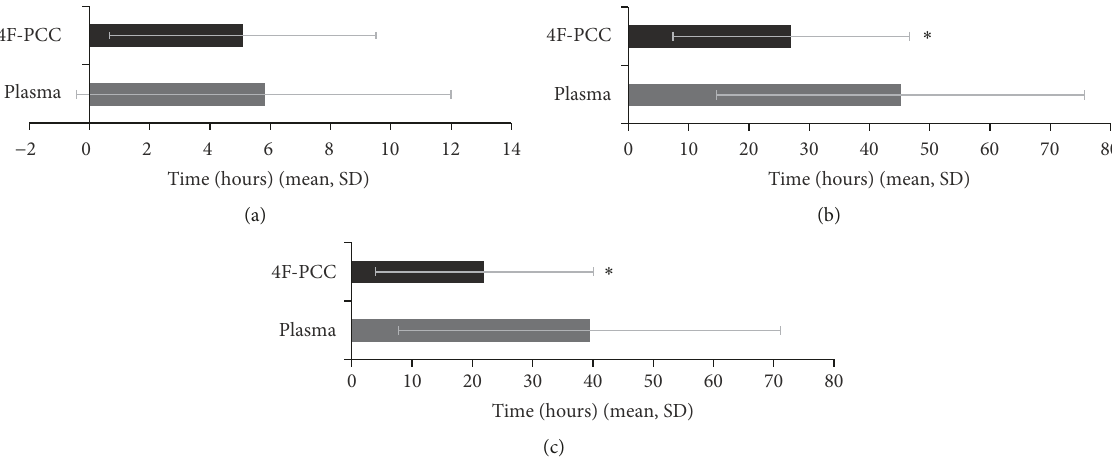
Figure 2: (a) Time between admission and start of study treatment. (b) Time between admission and first procedure. (c) Time between start of study treatment and first procedure. 𝑃 value for comparison of groups for times from admission to study treatment = 0.64. ∗ 𝑃 < 0.05 compared with plasma. 4F-PCC, 4-factor prothrombin complex concentrate; SD, standard deviation.